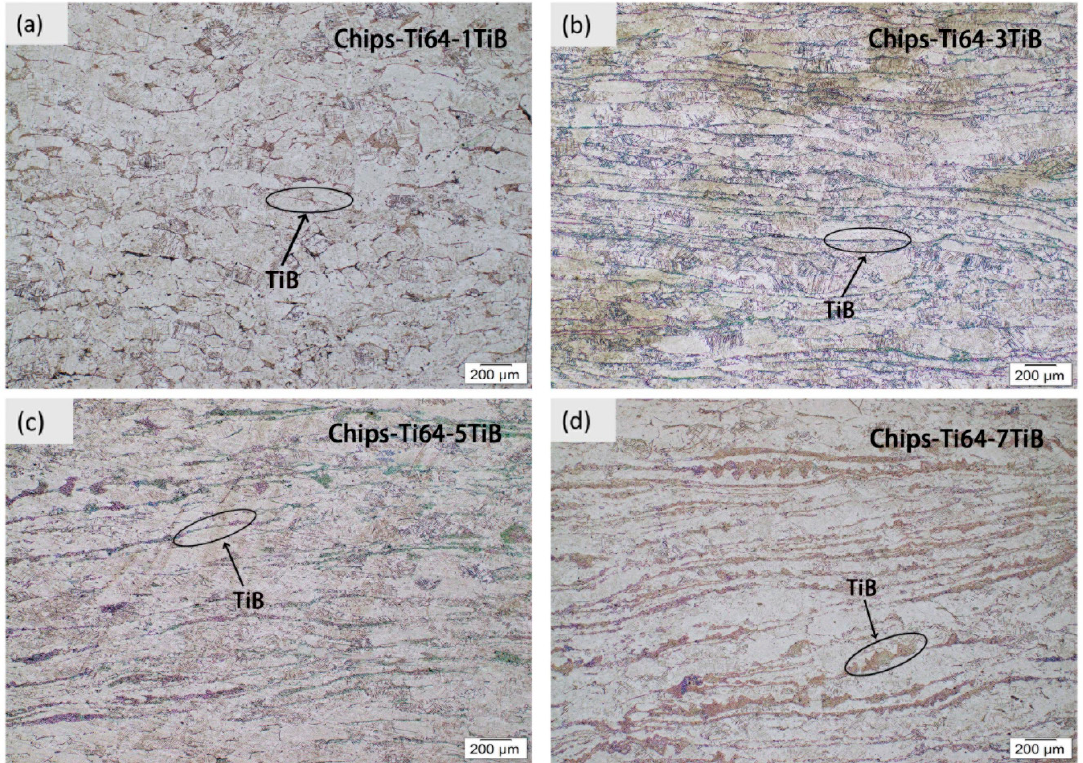
Figure 5. The optical microstructures of 1250 °C hot-pressed Chips-Ti64-xTiB composites: ( a ) Chips- Ti64-1TiB; ( b ) Chips-Ti64-3TiB; ( c ) Chips-Ti64-5TiB; and ( d ) Chips-Ti64-7TiB.